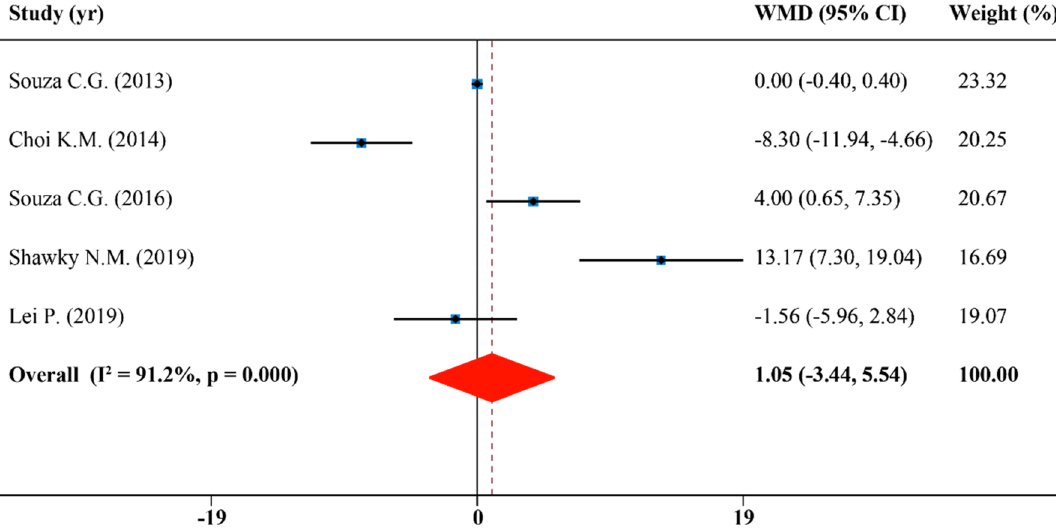
Figure 6. Forest plot showing effects of SFN on serum high-density lipoprotein cholesterol.